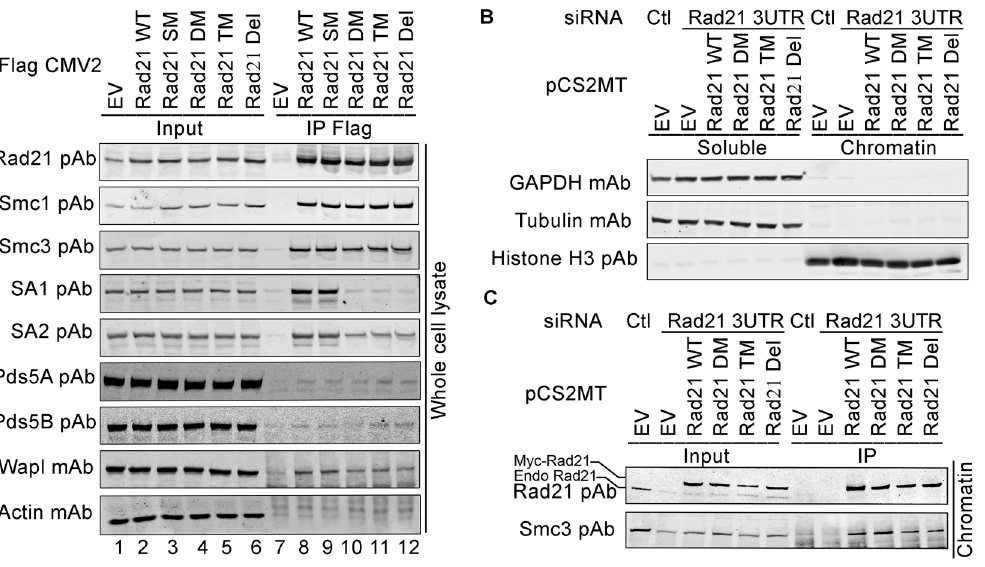
Figure 5. Co-immunoprecipitation of other cohesin subunits by Rad21 with mutations or deletion on MP SA-binding motif. ( A ) 293 T cells were transfected with pFlag CMV2 Rad21 WT or mutants and co-immunoprecipitation was performed using whole cell lysate. Cells transfected with empty vector (EV) was used as control. Immunoblotting shows the cohesin core subunits and associating proteins immunoprecipitated by Rad21 WT and mutants. ( B-C ) 293 T cells were transfected with pCS2MT Rad21 WT or mutants. EV was used as control. Endogenous Rad21 was knocked down with Rad21 3 9 -UTR siRNA. Scrabbled siRNA was used as control (Ctr). Proteins from chromatin fraction were isolated and used for IP. Immunoblotting shows the chromatin fraction was not contaminated by the soluble fraction (B) and like WT Rad21, mutant Rad21 was found on chromatin and co-immunoprecipitated by cohesin-Smc3 (C). EV: empty vector, WT: wild type, DM: L385A T390A, TM, L385A F389A T390A, Del: del(383–392